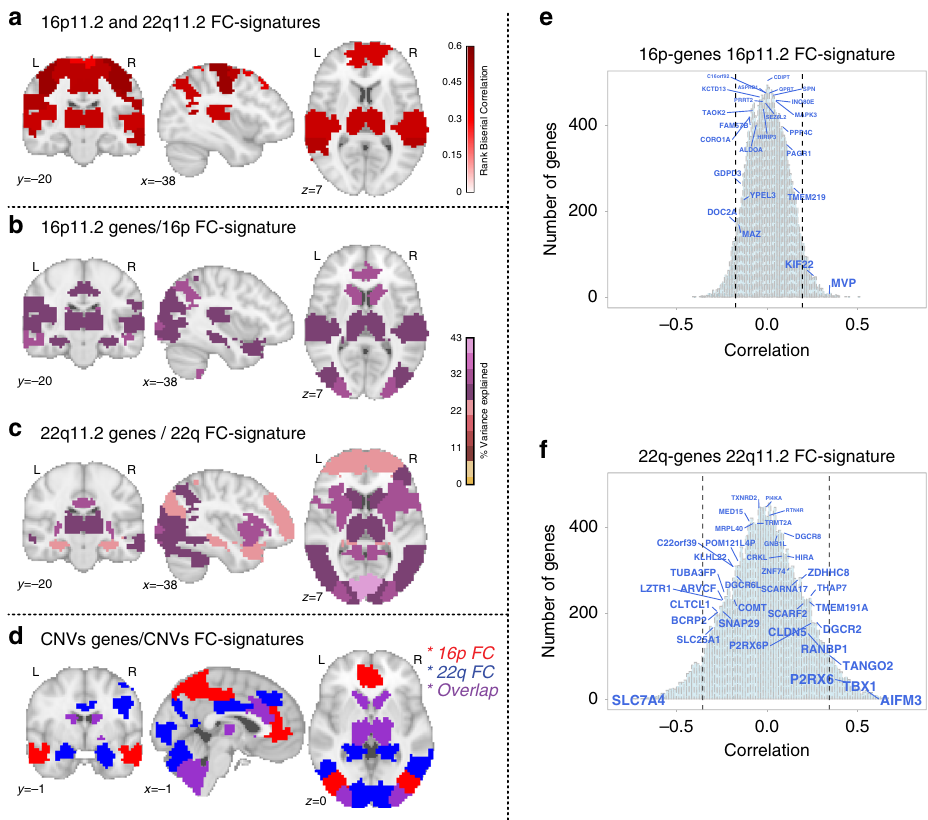
Fig. 6 FC similarities between CNVs and relationship with gene expression. a FC similarities between both deletions at the regional level. The values in the brain map represent the level of the FC similarity between deletions (rank biserial correlation, Mann – Whitney test). The values are thresholded (FDR, 64 regions): 18 out of 64 regions are similar between deletions. b Relationship between spatial patterns of gene expression within the 16p11.2 locus and regional FC signatures of the 16p11.2 deletion. A partial least square regression (PLSR) was conducted for each of the 64 regions. Maps are thresholded (FDR corrected for 64 regions) and color code represents the percentage of variance explained by gene expression using two components in the PLSR. c The same analysis was conducted for 22q11.2 genes and the 22q11.2 deletion FC signature. b , c Eleven regions overlapped across PLSR maps: thalamus, caudate, anterior insula and posterior insula sulcus, amygdala and hippocampus, cerebellum 9 and right crus-2, dorsal anterior cingulate, left inferior parietal lobule, medial posterior visual network, lateral posterior visual network, and dorsal visual network. Three (over the 18) regions identi fi ed in the between deletion similarity ( a ) analysis are also present in the gene expression/FC-signature association maps ( b , c ): Thalamus, dorsal anterior cingulate, and left inferior parietal lobule. d Low speci fi city for the relationship between spatial patterns of gene expression and regional FC deletion signatures. In red: the 16p11.2 regional FC associated with the expression patterns of both the 16p11.2 and the 22q11.2 genes. In blue, the 22q11.2 regional FC is associated with the expression patterns of genes in both genomic loci. In purple, seven regions were found with both deletion FC-signatures, and the expression patterns of genes encompassed in both genomic loci. e , f Expression patterns of genes within and outside CNVs correlate with FC-signatures of 16p11.2 and 22q11.2 deletions. The light blue histogram represents the distribution of correlations for 15663 genes with available gene expression data from the AHBA. X -axis values: Pearson coef fi cients. Y -axis values: number of genes. Genes within the CNVs have font-size scaled based on p values. Dotted lines represent the 5th and 95th percentiles of the correlation distribution